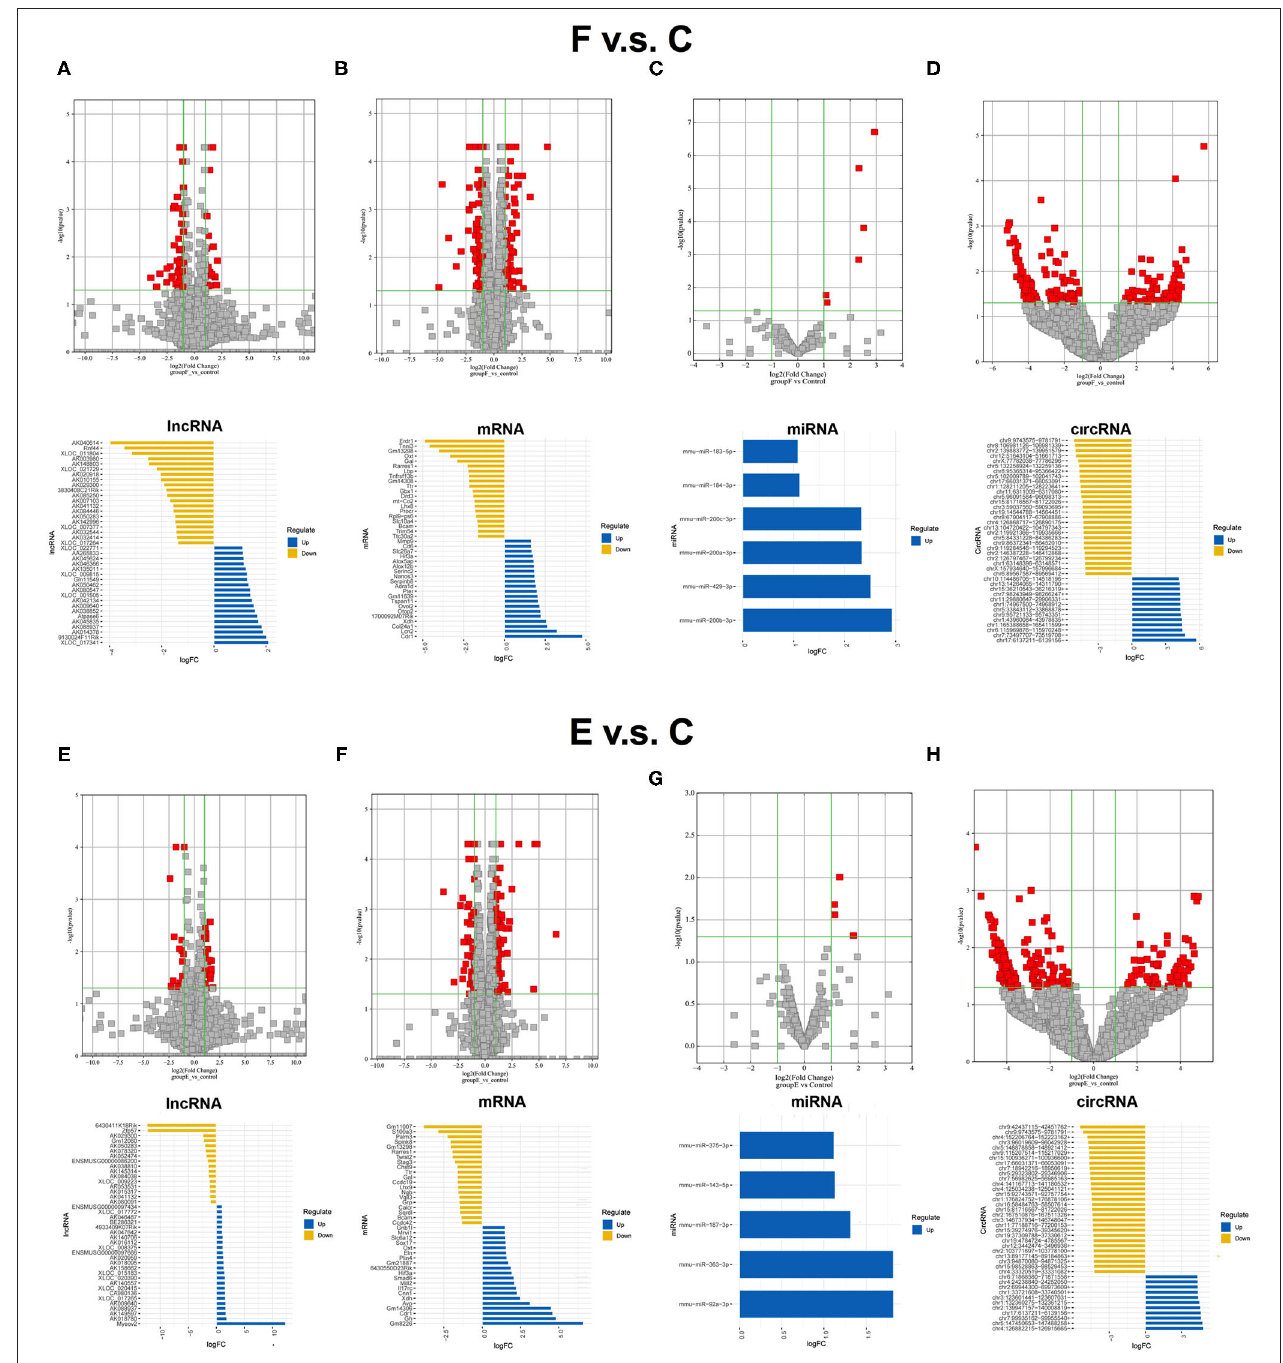
FIGURE 1 | Expression profiles of distinct RNAs between F and control groups, and E and control groups. (A) In the volcano plots, red and gray points represented abnormal lncRNAs and non-significantly DELs, respectively, in F and control groups. The top 20 upregulated genes (blue) and the top 20 downregulated (yellow) genes were presented. Expression profiles were similarly shown for mRNA (B) , miRNA (C) , and circRNA (D) . (E) In the volcano plots, red and gray points represented abnormal lncRNAs and non-significantly differentially expressed lncRNAs, respectively, in (E) and control groups. The top 20 upregulated genes (blue) and the top 20 downregulated (yellow) genes were presented. Expression profiles were similarly shown for mRNA (F) , miRNA (G) , and circRNA (H) . F, fear memory formation group. E, fear memory extinction group. miRNA, micro-RNA; circRNA, circular RNA; lncRNAs, long non-coding RNAs.